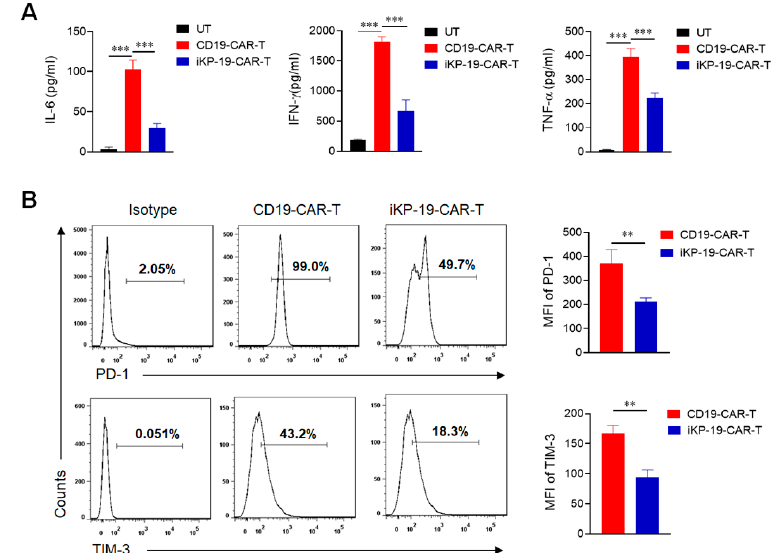
Figure 5. Cytokines release and exhaustion marker expression of iKP-19-CAR-T cells after coculture with Burkitt’s lymphoma Daudi cells. iKP-19-CAR-T cells or CD19-CAR-T cells and Daudi cells were co-cultured in 96 well plate at a 1:1 ratio for 6 h in RPMI complete media. ( A ) Cell culture media were collected and IL-6, IFN- γ and TNF- α were determined by flow cytometry using CBA assay kit ( n = 4 different donors). ( B ) CAR-T cells were collected and stained with FITC-anti-human PD-1 antibody and PE/Cy7-anti-human TIM-3 antibody to measure the expression of exhaustion markers PD-1 and TIM-3 ( n = 4 di ff erent donors). MFI was statistically analyzed from three di ff erent experiments of each donor. ** p < 0.01, *** p < 0.001. Error bars represent ±